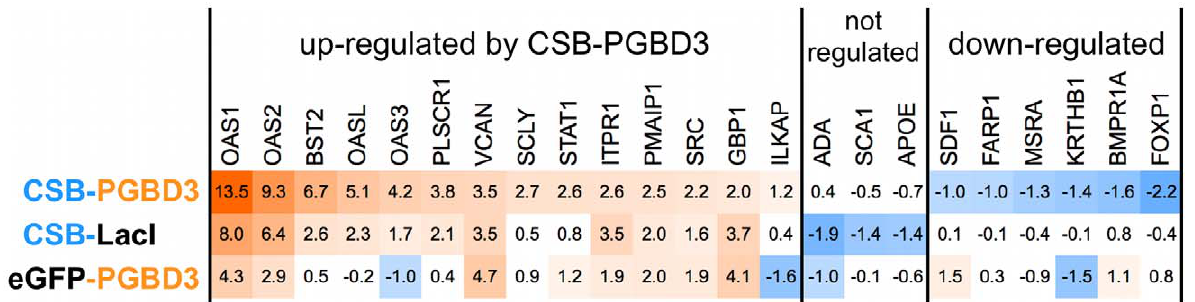
Figure 11. CSB-LacI and eGFP-PGBD3 induce partial up-regulation of genes regulated by CSB-PGBD3. Average signal log ratios from quantitative PCR (QPCR) of genes regulated by CSB-PGBD3, CSB-eGFP, or eGFP-PGBD3 expression in UVSS1KO cells compared to cells expressing FLAG-HA-tags alone. Orange cells: increased expression; Blue cells: decreased expression; No color: expression change was less than 2-fold (1 signal log ratio); darker color indicates a larger change in expression.